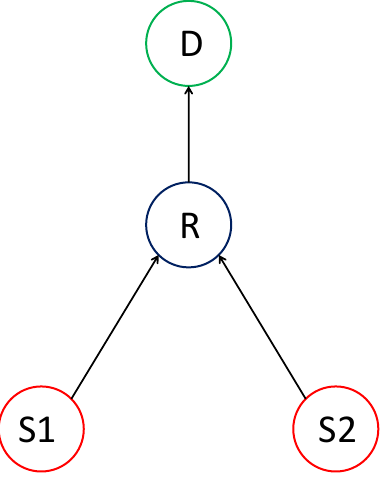
Figure 1. The Y-network